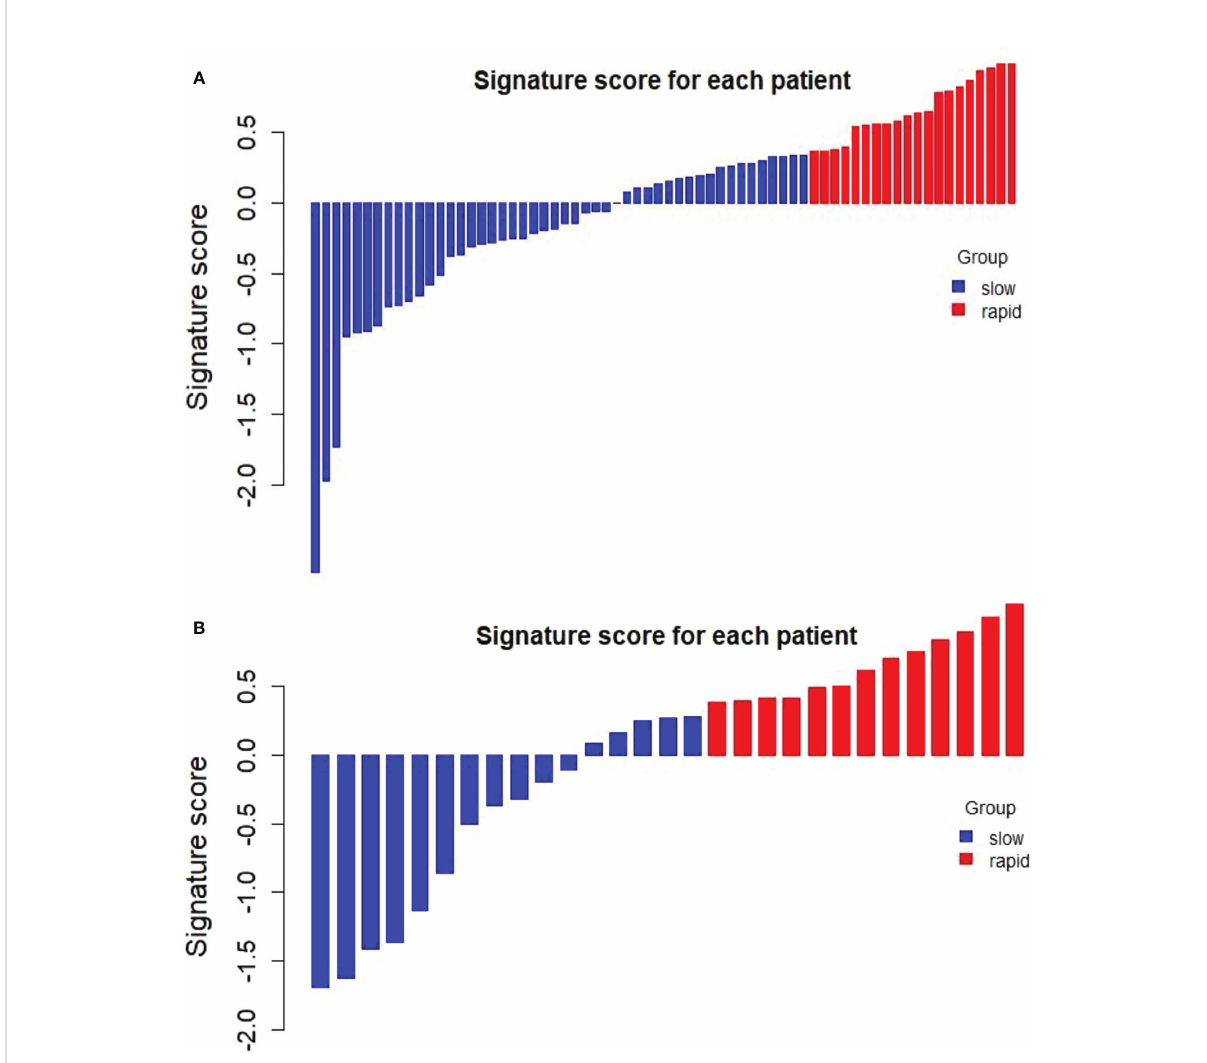
FIGURE 3 Distribution of delta radiomics scores in the training cohort (A) and validation cohort (B) . Delta radiomics scores above the cut-off value were categorized as the RP subgroup (red), and delta radiomics scores below the cut-off value were categorized as the SP subgroup (blue). There was an obvious difference in the distribution of the Delta Rad-score between the RP and SP